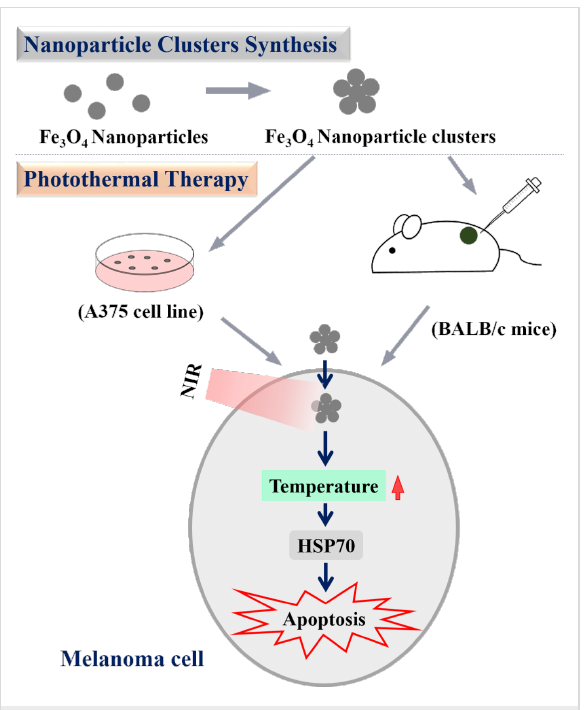
Figure 6: Schematic representation of Fe 3 O 4 NPC-mediated photothermal therapy in